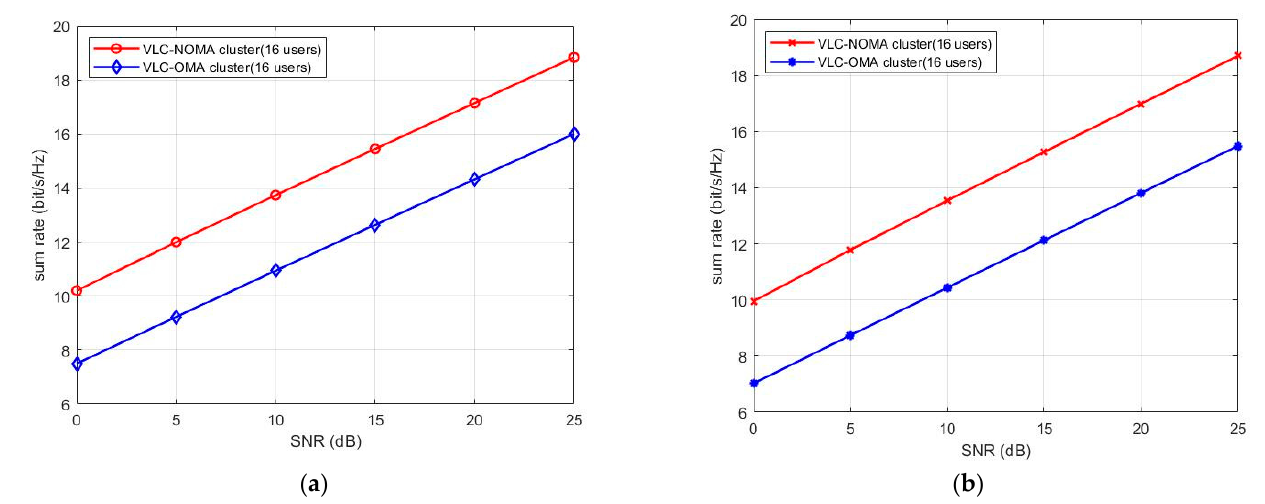
Figure 4. ( a ) Sum rate of NOMA and OMA under the same QoS. ( b ) Sum rate of NOMA and OMA under different QoS.